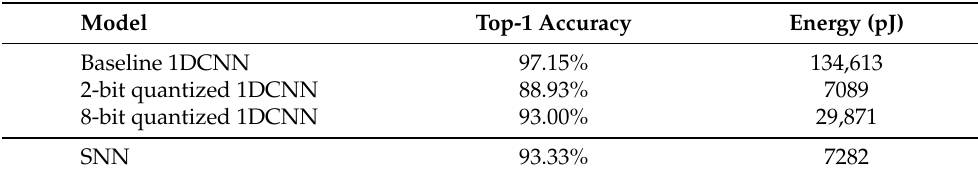
Table 5. SNN Accuracy and Energy